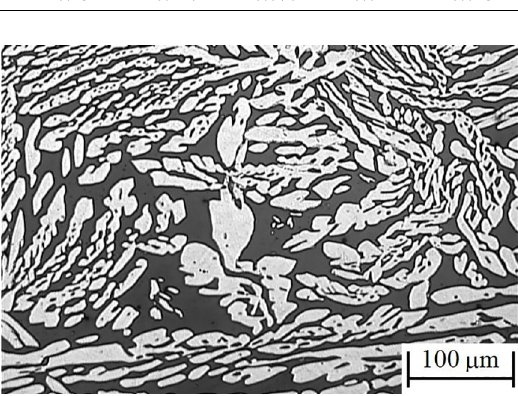
Figure 1. Microstructure of the cast DSS solution treated. Austenite is light and ferrite is dark. Beraha’s etching.